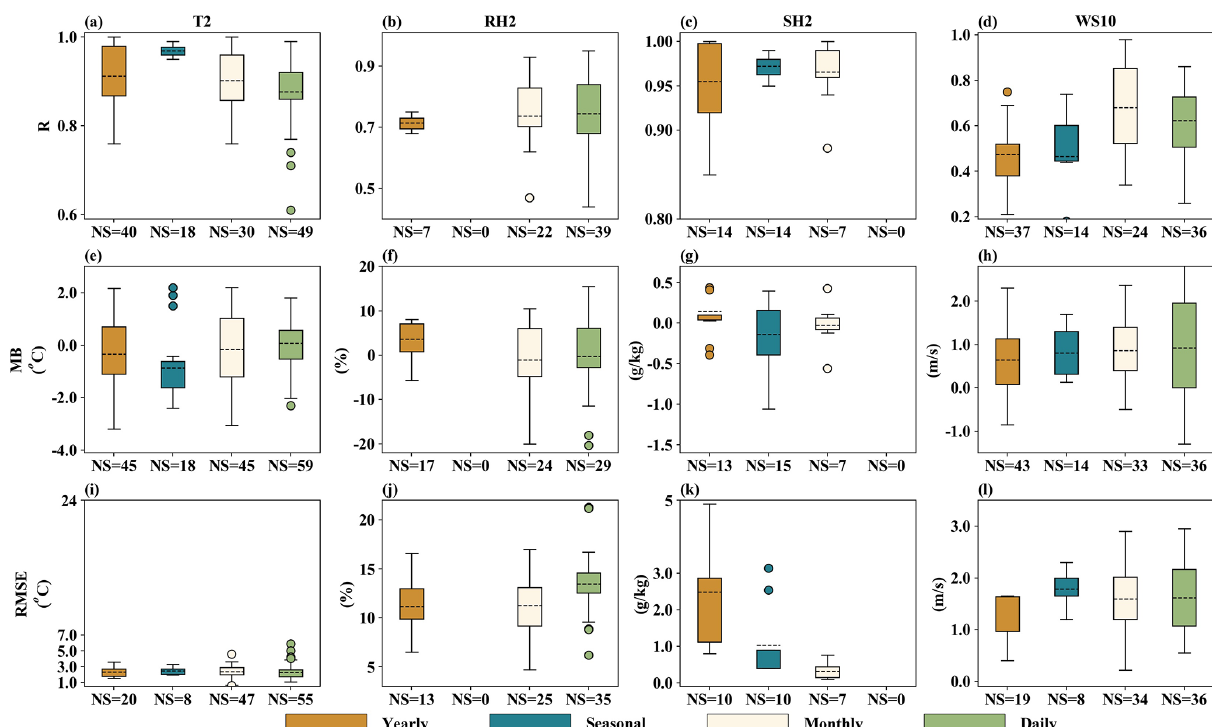
Figure C1. The statistical indices of modeled meteorological variables at different temporal scales (yearly, seasonal, monthly, and daily) from past studies in Asia.